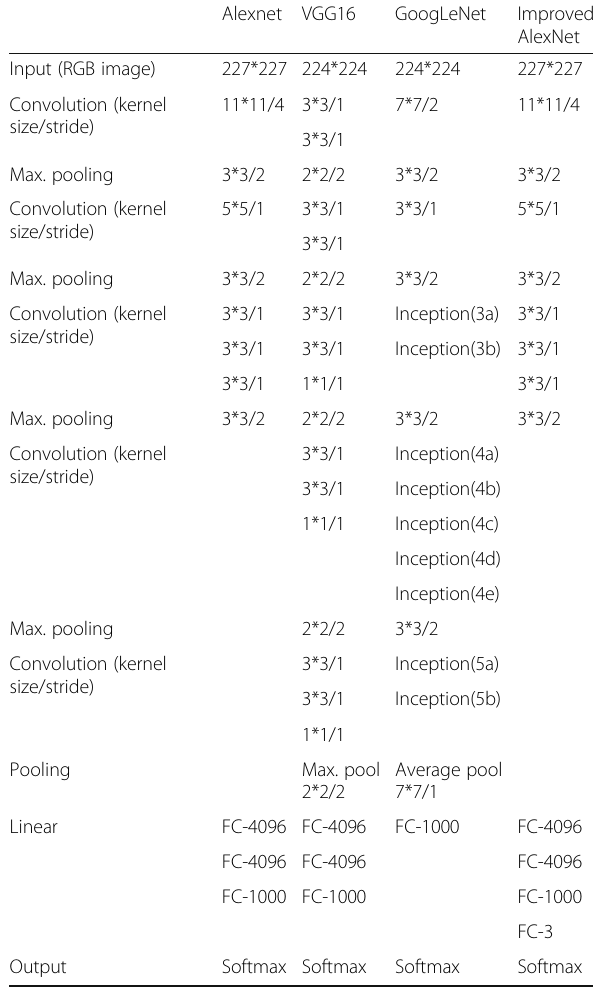
Table 2 Detailed descriptions of AlexNet, VGG-16, and